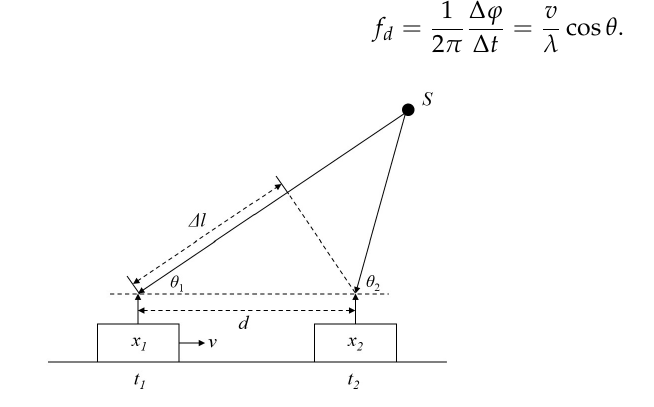
Figure 2. Doppler